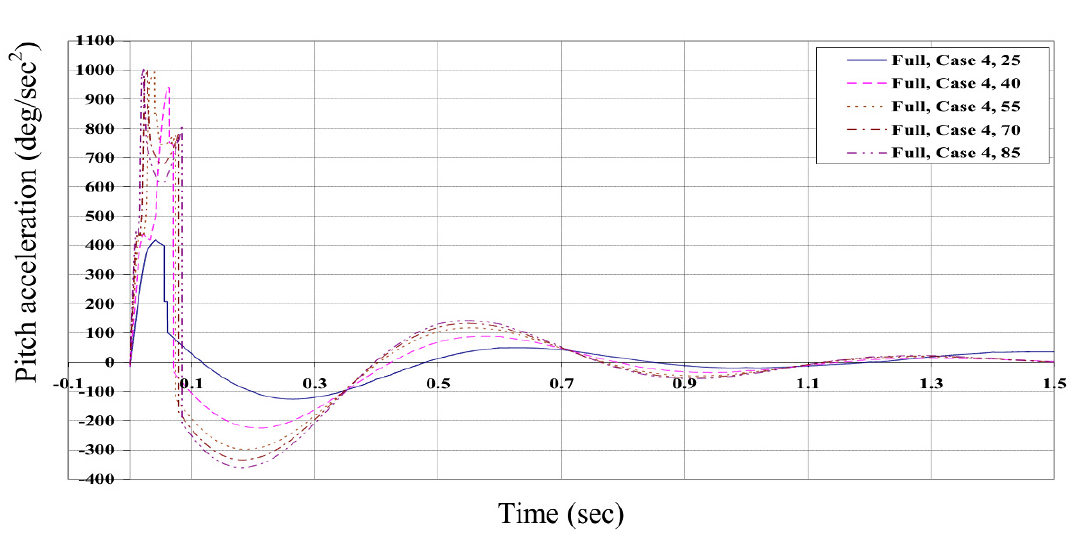
Figure 25. Pitch acceleration of the vehicle body at the different five speeds with case 4.